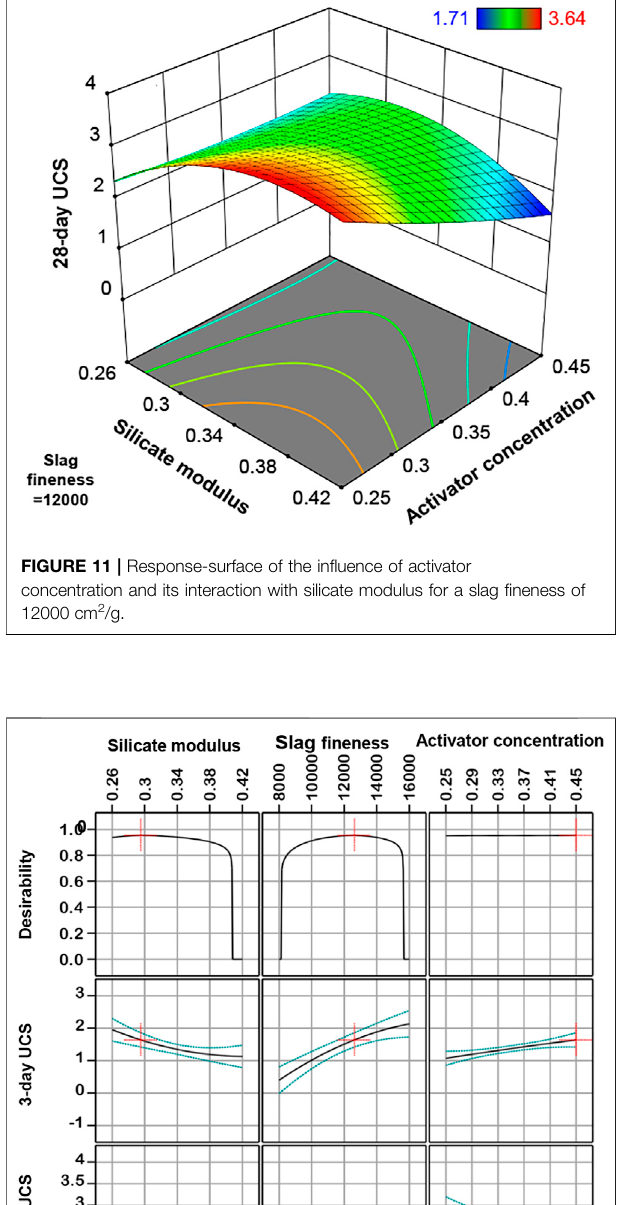
FIGURE 10 | Response-surface of the in fl uence of slag fi neness and its interaction with silicate modulus for an activator concentration of 0.35.